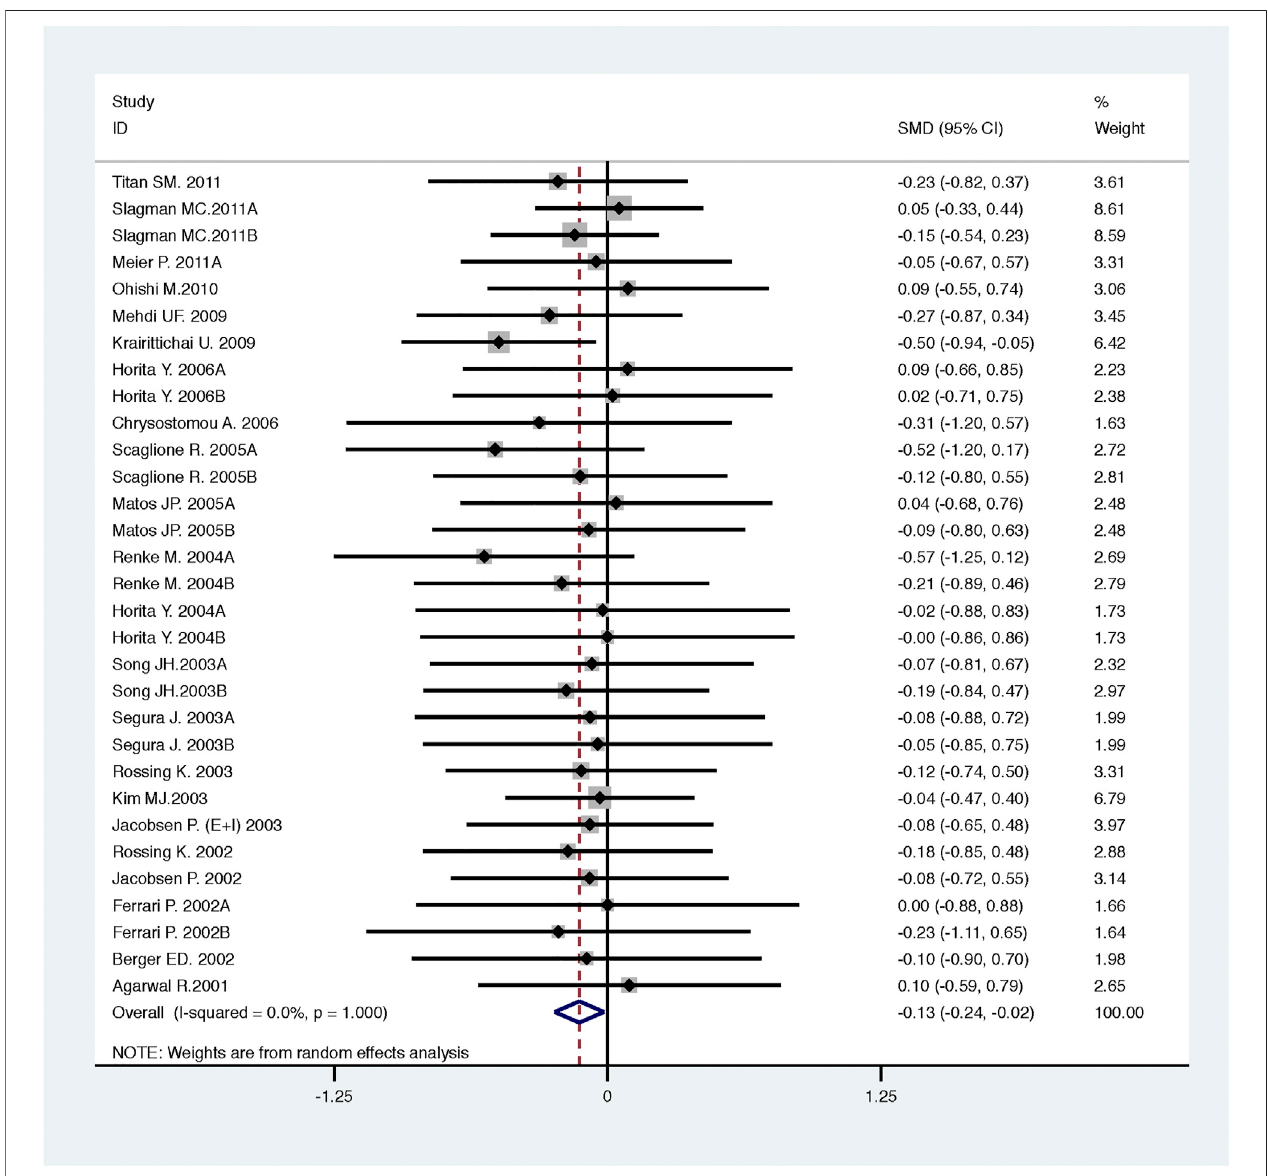
FIGURE 5 | Comparison of ACEI in combination with ARB vs. low-dose ACEI or ARB for glomerular fi ltration rate (mL/min or mL/min/1.73m 2 ).